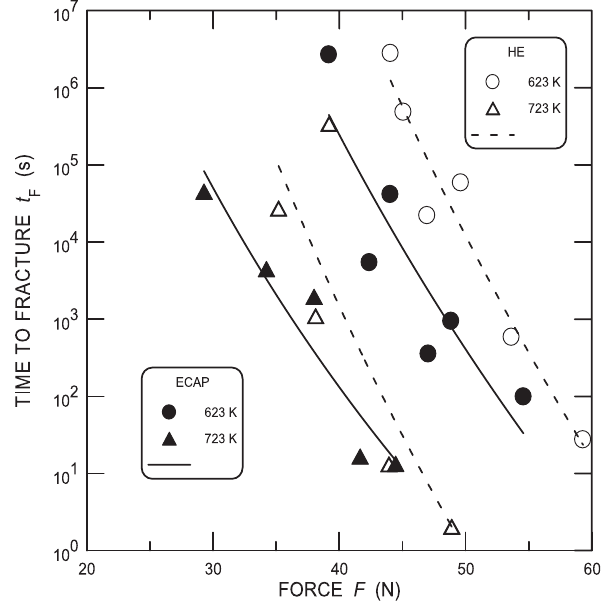
Fig. 22: Dependence of the time to fracture on the applied force